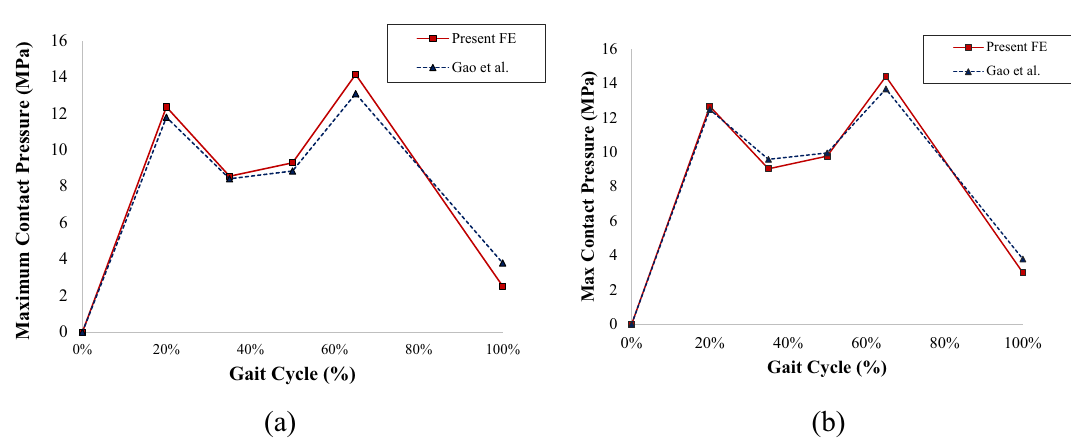
Figure 4. Contact pressure validation with Gao et al. 31,37 : ( a ) single-mobility, ( b ) dual-mobility hip joint prosthesis